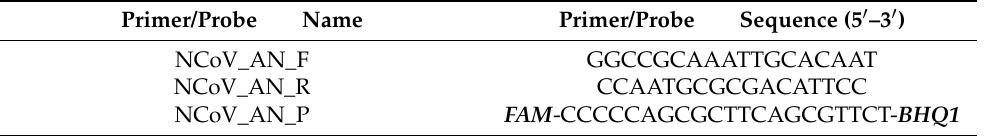
Table 2. Primers and probe used for RT